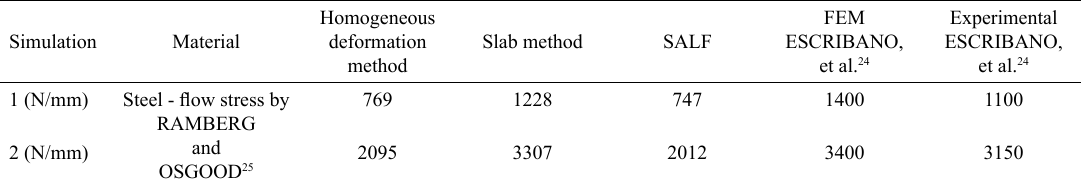
Table 2. Force versus reduction - simulation 1: reduction of 5%; simulation 2: reduction of 30%. Simulation